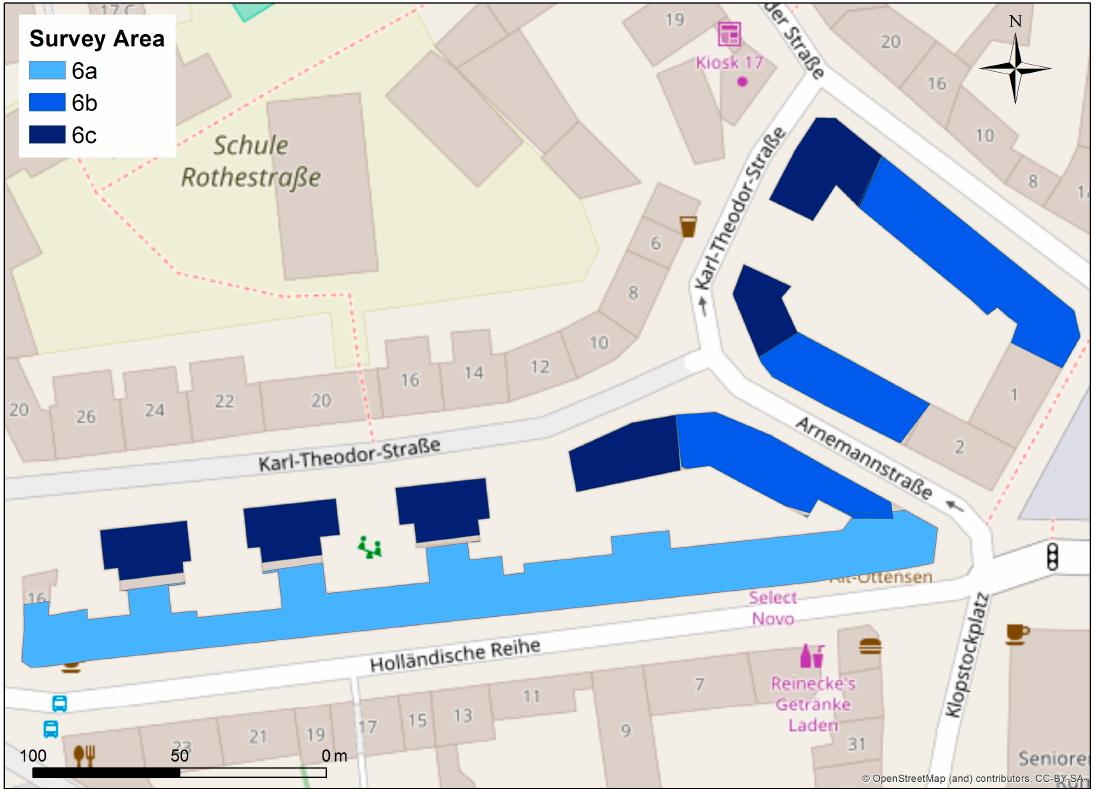
Figure 2. Subareas of survey area 6—typical layout of an inner-city survey area.